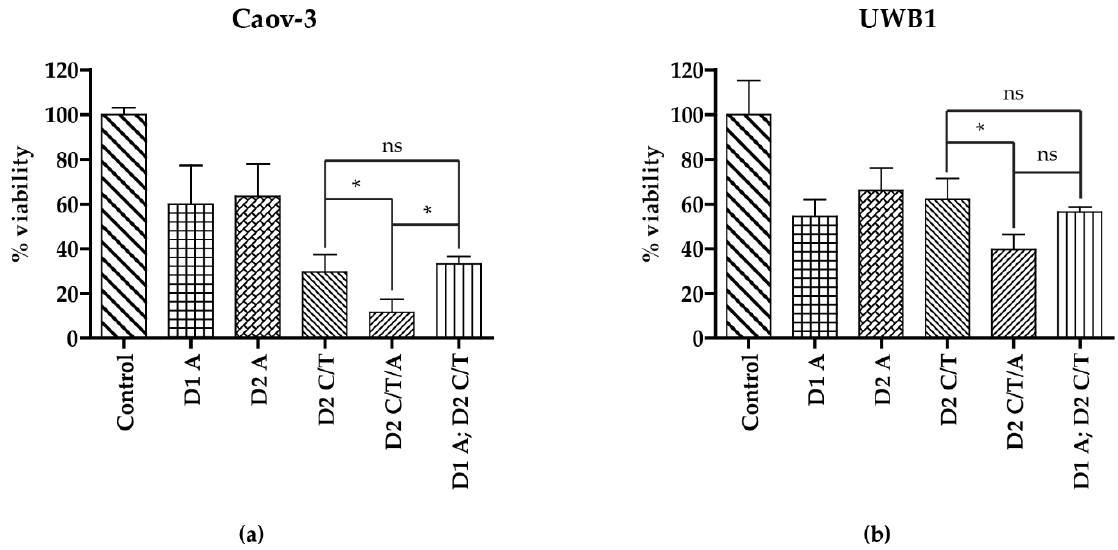
Figure 5. Drug Administration Sequence Assay for artesunate, carboplatin, and paclitaxel. Cells were treated with artesunate on day 1 (D1A) or day 2 (D2A), carboplatin and paclitaxel on day 2 (D2C/T), carboplatin, paclitaxel, and artesunate on day 2 (D2C/T/A), or artesunate on day 1 followed by carboplatin and paclitaxel on day 2 (D1A; D2C/T). The 24 h treatment concentrations for artesunate, carboplatin, and paclitaxel were 40 μM, 16 μM, and 32 μM, respectively. Percent viability was calculated utilizing the CellTiter-Glo 2.0 viability assay following treatment with carboplatin/paclitaxel and/or artesunate compared to DMSO-treated (control) cells, as indicated, shown graphically as the mean +/− SD in Caov-3 ( a ) and UWB1 ( b ) cells. Statistical differences were assessed by One-way ANOVA (ns—not significant and * p < 0.05). In both cell lines, the addition of artesunate as a concurrent treatment with carboplatin/paclitaxel resulted in a significant decrease in viable cells.